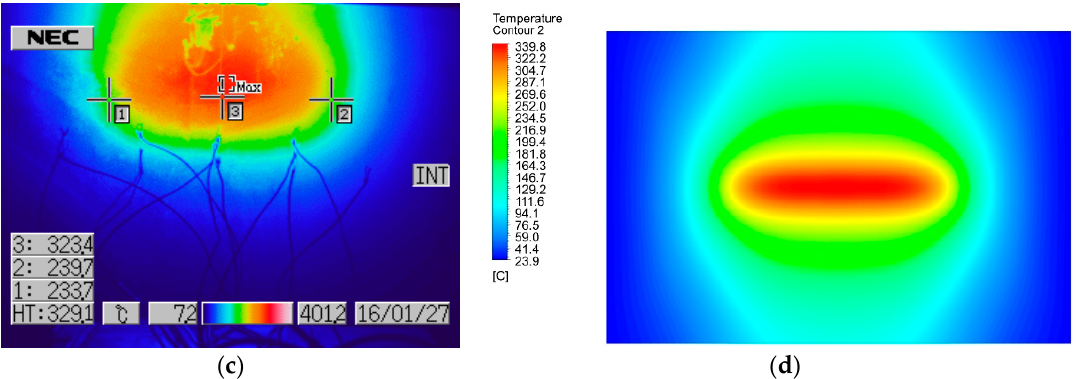
Figure 15. Steel-plate temperature distribution at the back side with incomplete combustion ( Φ = 1.4): ( a ) basic model experiment; ( b ) basic model simulation; ( c ) modified model experiment; ( d ) modified model simulation.